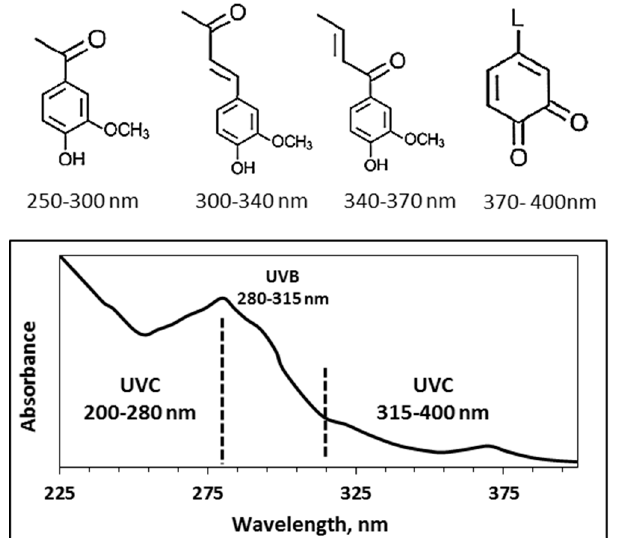
Figure 2. Chromophores in lignin structure and their UV absorption spectra, reprinted and redrawn by the authors [6,10,11].